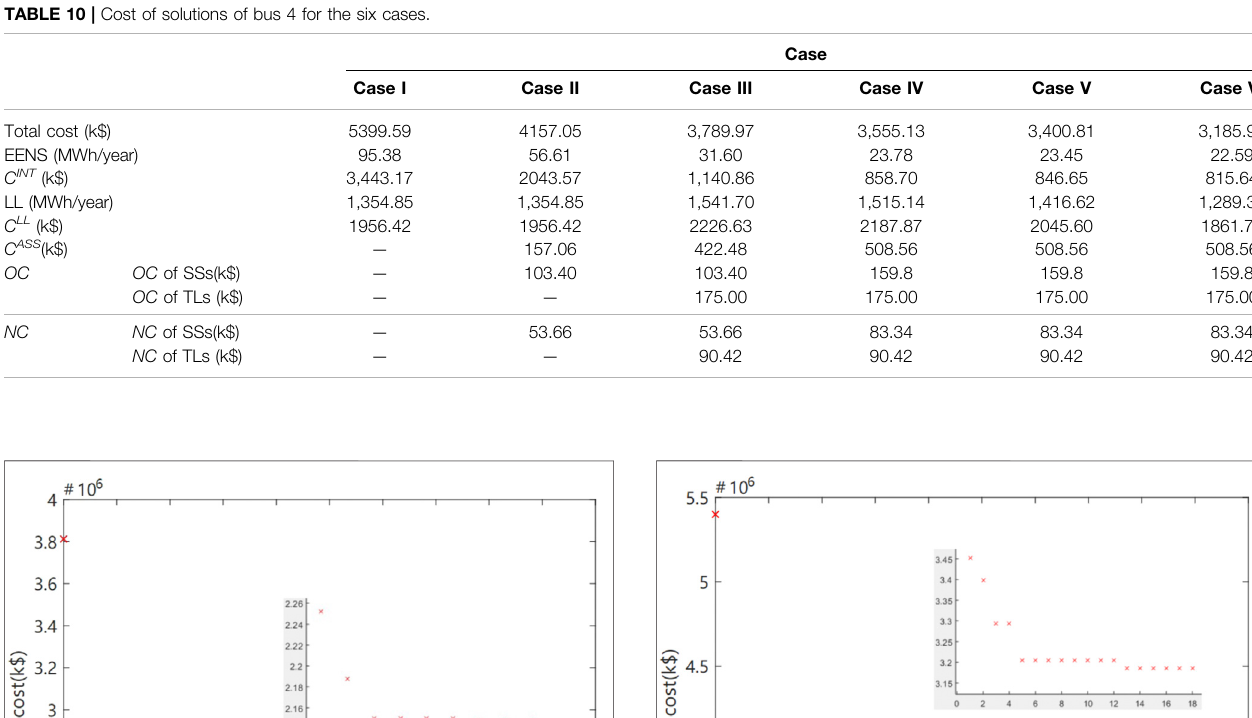
TABLE 10 | Cost of solutions of bus 4 for the six cases.